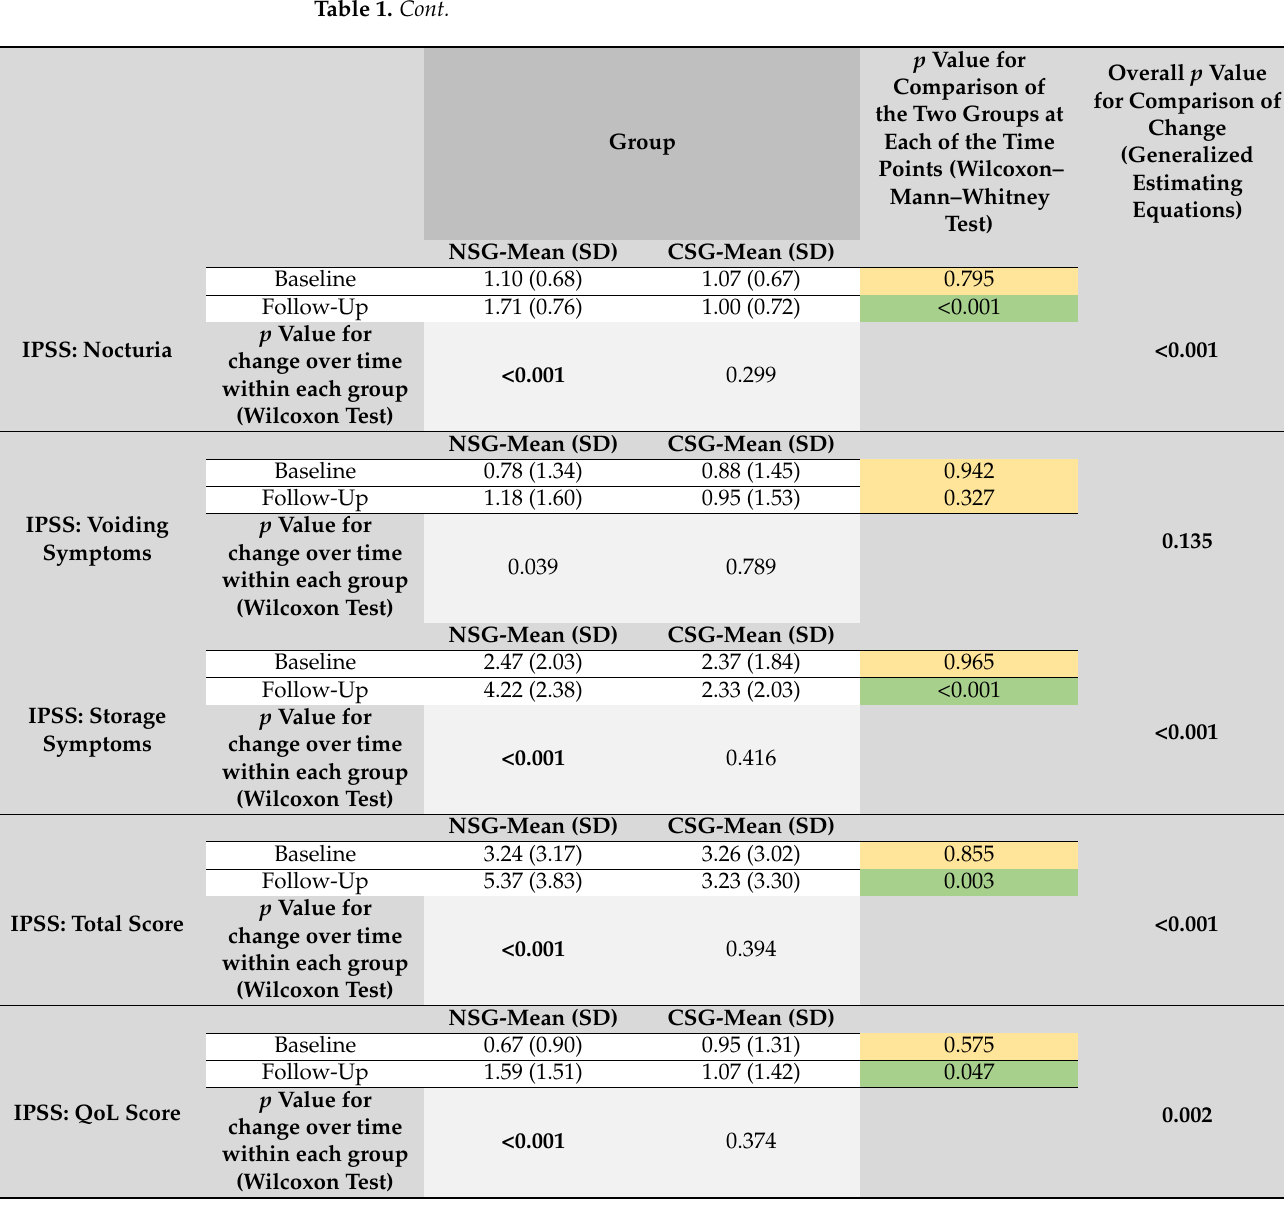
p Value for Comparison of the Two Groups